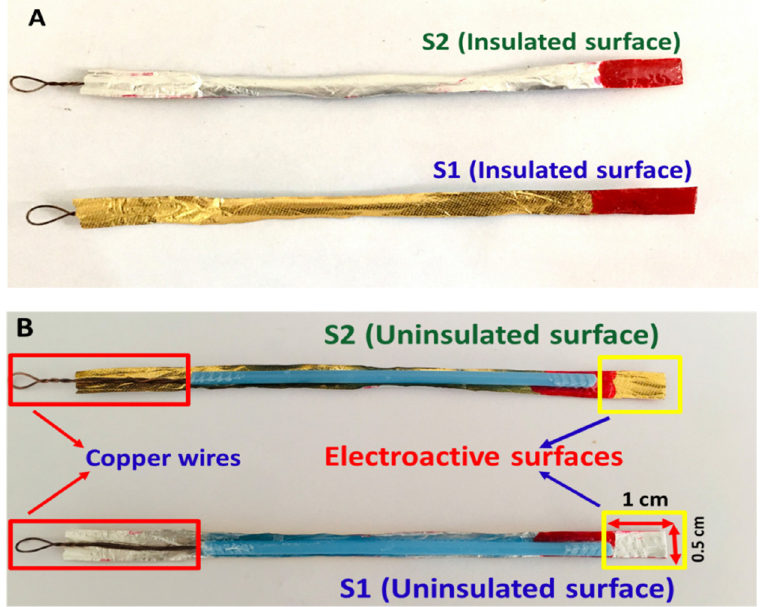
Figure 10. The insulated ( A ) and uninsulated ( B ) surfaces for the S1 and S2 electrodes, fabricated from the chocolate aluminum wrapping foils where the geometric surface areas for both electrodes are 0.5 cm 2 . Both the uninsulated surfaces will be used as electroactive surfaces for electrochemical characterization.